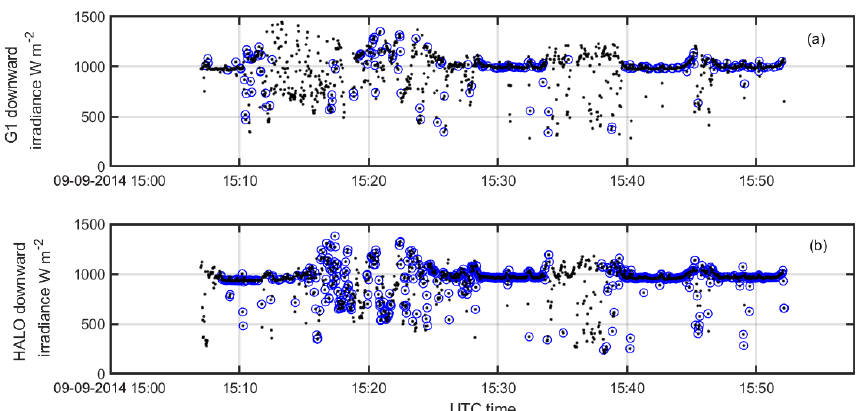
Figure 16. Time series of the G1 and HALO downward irradiance on 9 September (a) by SPN1 and (b) by SMART-Albedometer. Black dots represent all data under the general intercomparison criteria. The blue circles represent the restricted navigation